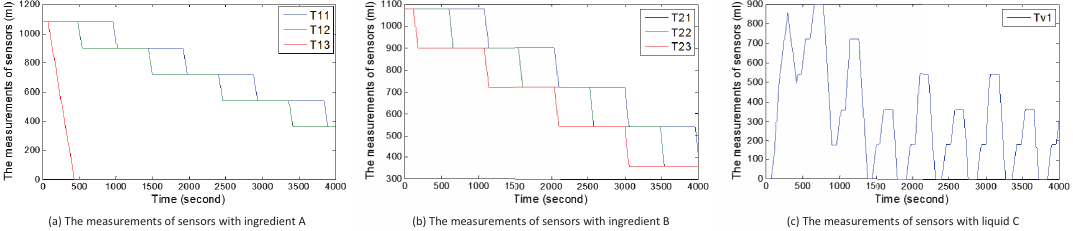
Figure 14. Measurements from sensors under attack case